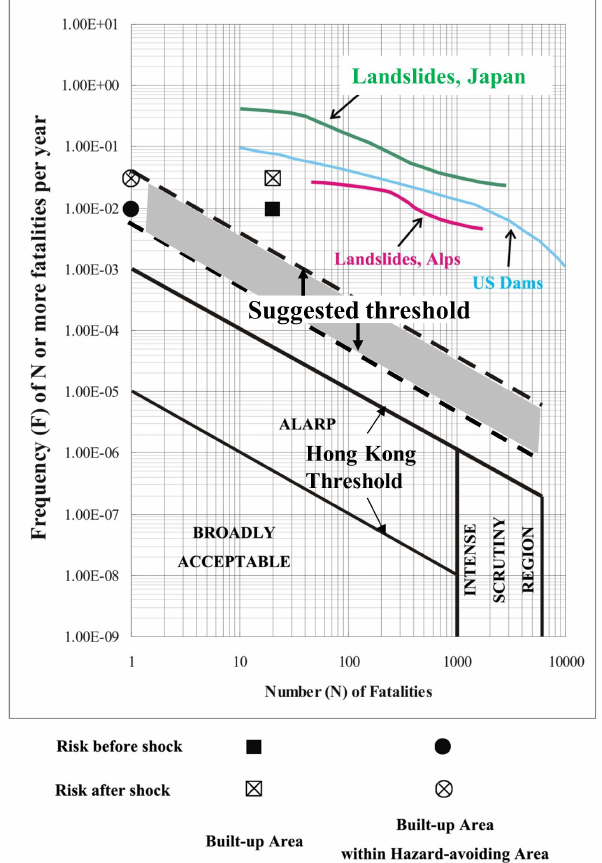
Fig. 6. The societal risk of debris flow in both the settlement area and the low hazard settlement area. The risk criterion proposed by ERM-Hong Kong Ltd (1998) is presented. Dashed lines indicate the suggested range of threshold for the debris flow risk in Jiegu town- ship at a regional scale. YE refers to the 14 April 2010 M s = 7.1 Yushu Earthquake. ALARP is the abbreviation for “as low as rea- sonably practicable”. The landslide risk at a national scale in Japan and a large regional scale in Alps (Ashby and Lenting, 2003) are also shown, suggesting the establishment of risk criteria is a scale and site related